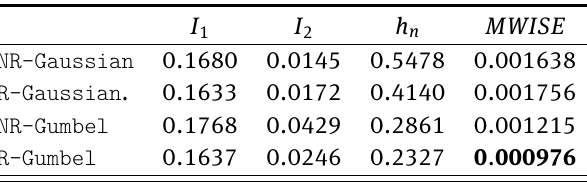
Table 3: The comparison between the plug-In MWISE of the four considered estimators using the proposed real data. The bold values indicate the smallest values regarding the plug-In MWISE I 1 I 2 h n